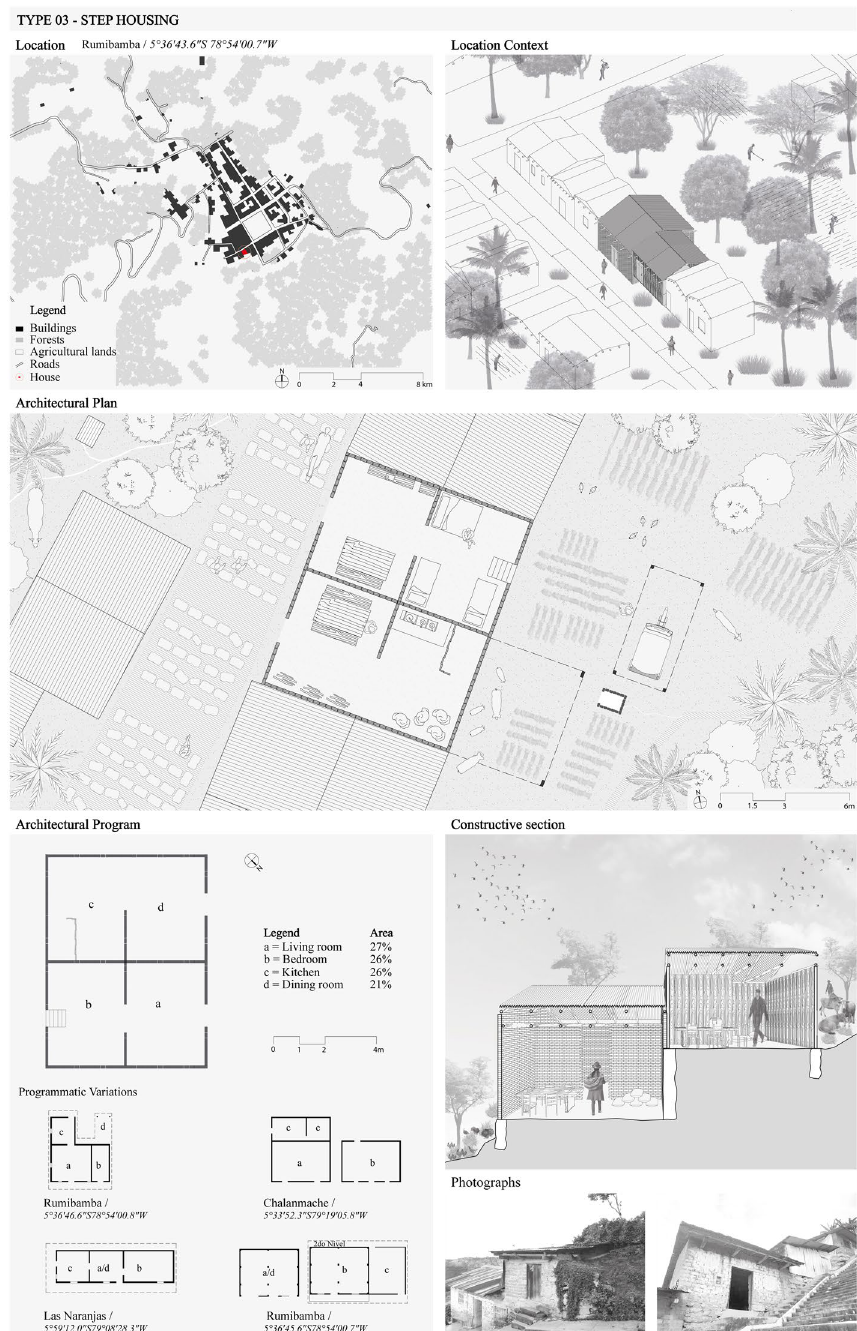
Fig. 4 Architectural characteristics of the “stepped” housing type (Source: the